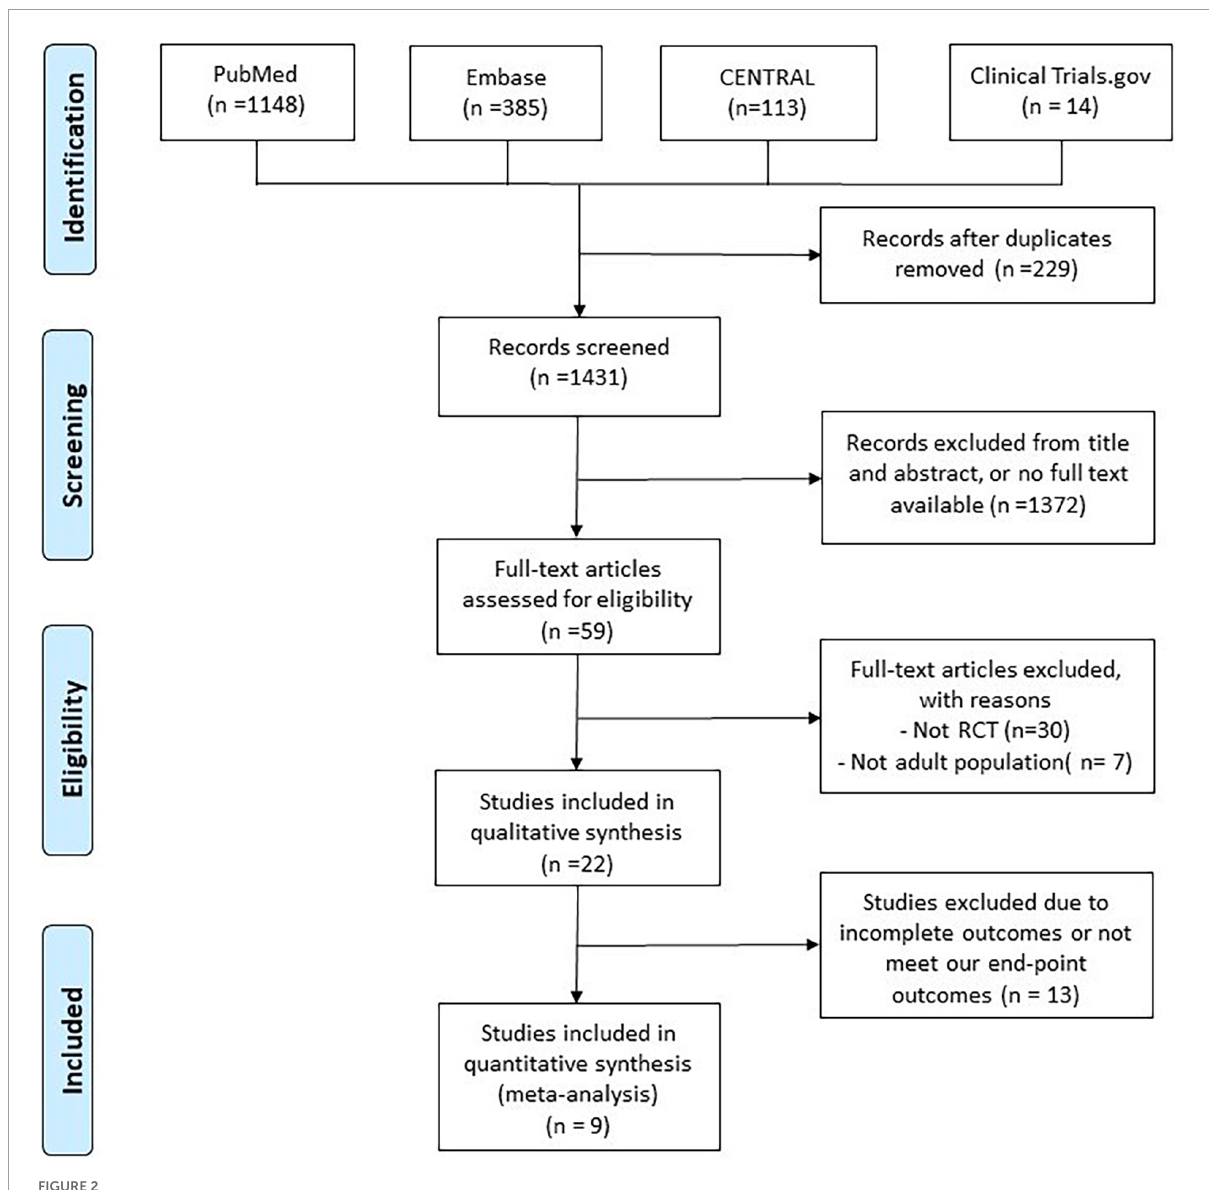
FIGURE2 Risk of bias in each domain in each